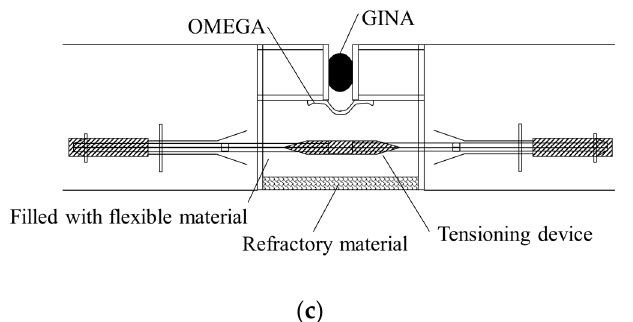
Figure 1. The different types of immersed tunnel joints (redrawn according to Wei and Lu [17] and Xue [18]). ( a ) Semi-flexible to semi-rigid joint. ( b ) Semi-rigid joint. ( c ) Flexible joint.